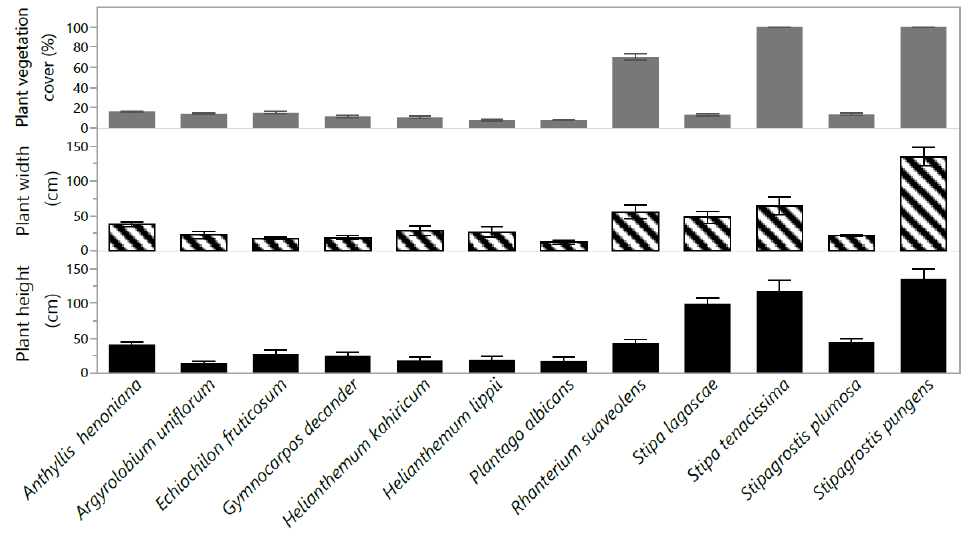
Figure 1. Plant height (cm), width (cm), and vegetation cover (%) of twelve native perennial species from arid rangelands of southern Tunisia. Values are the means ± standard error (SE) from 3 replicates (means ± SE).